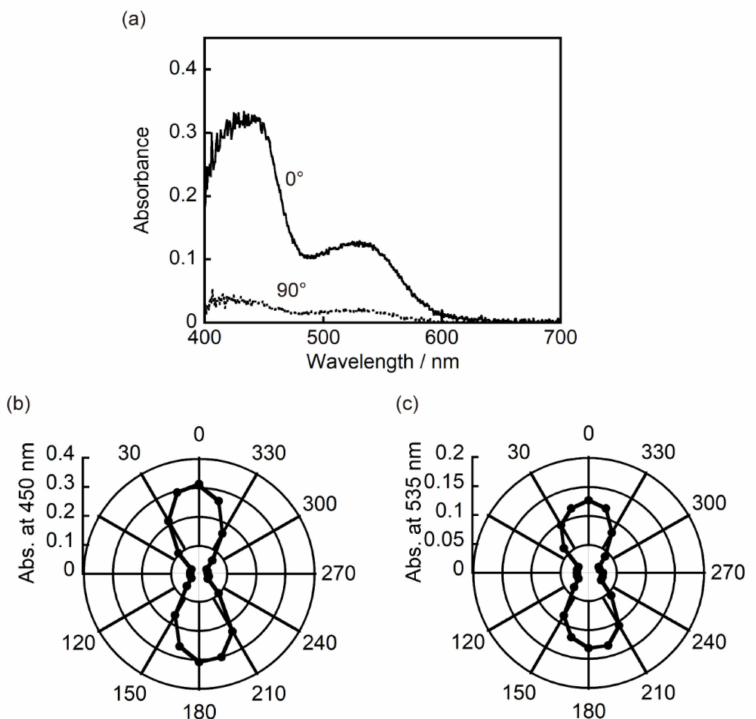
Figure 6. Polarized absorption spectra ( a ) and polar plots of absorbance ( b , c ) of an orange two- component mixed crystal ( 1a : 2a = 85:15, entry 2 in Table 2) after irradiation with 365 nm light. The absorption spectra were measured on ( − 1 1 0) face. The direction of 0 ◦ was set to the angle where the maximum absorbance was observed. In the polar plots, the absorbance at 450 nm ( b ) and 535 nm ( c ) was monitored.